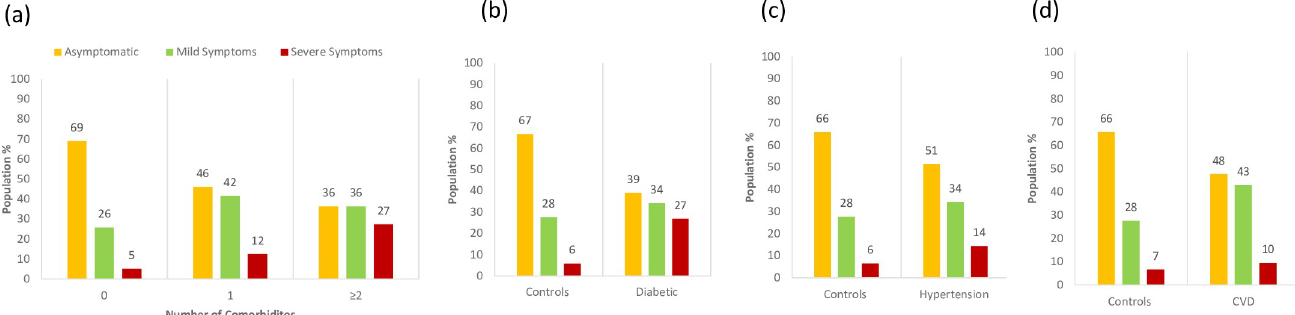
Fig 3. Effects of comorbidities on COVID-19 severity. (a) Symptomology in COVID-19 patients classified based on the number of comorbidities. (b) Symptomology in COVID-19 patients with diabetes versus the control group. (c) Symptomology in COVID-19 patients with hypertension versus the control group. (d) Symptomology in COVID-19 patients with cardiovascular diseases versus the control group.